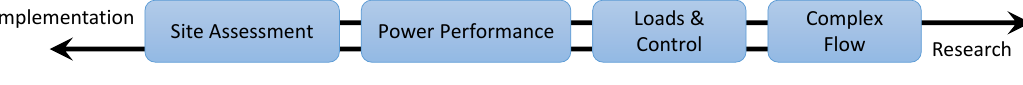
Figure 1. Barriers to the use of lidar technology in wind energy applications are mostly related to implementation and